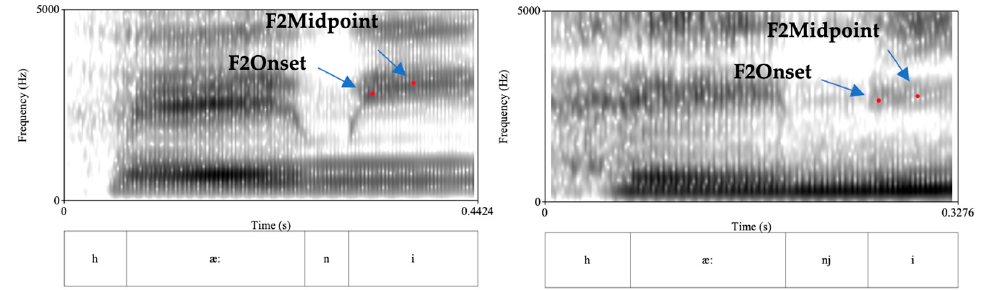
Figure 1. Spectrograms from two women: one non-palatalizer ( left ), showing a lower F2 at the ‘i’ vowel onset, and one palatalizer ( right ), showing higher F2 at onset, saying [hæ:ni] ‘male name, Hanny’.